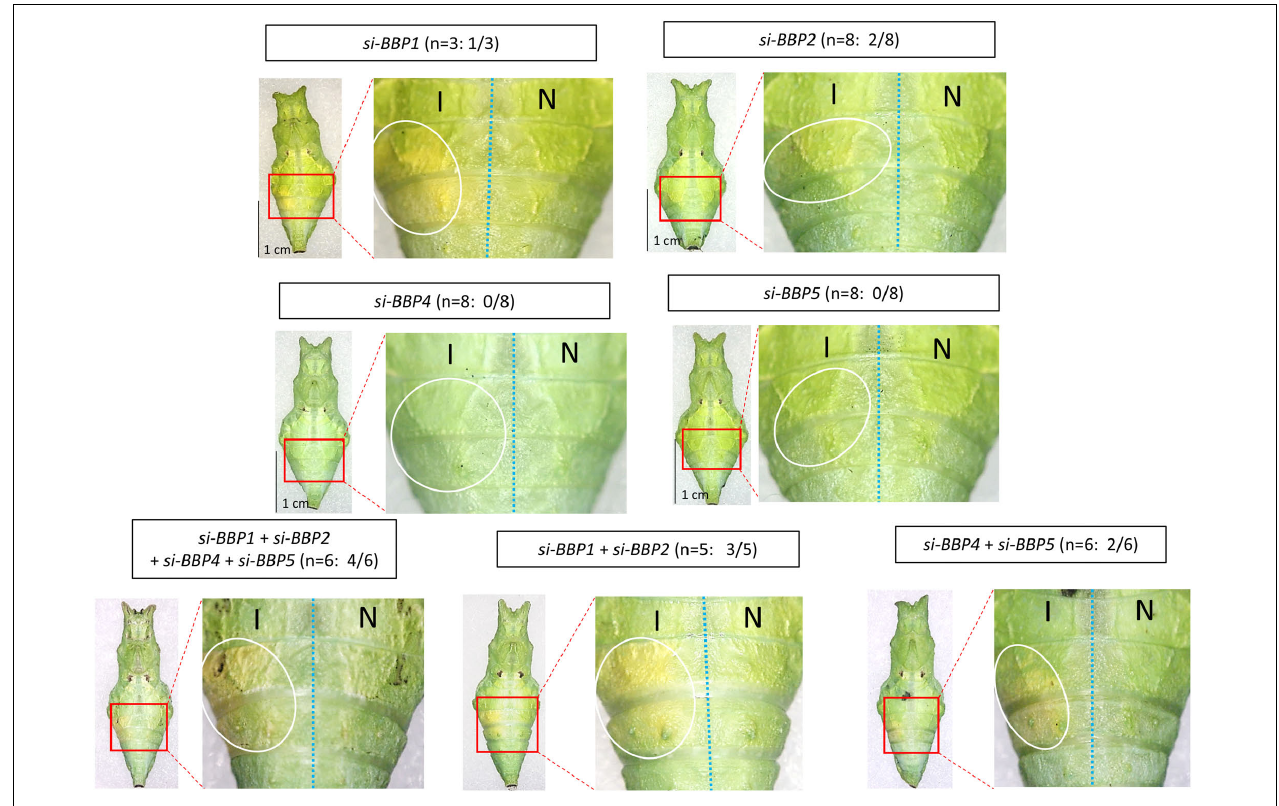
FIGURE 7 | Knockdown of BBP genes in green-conditioned pre-pupae. By an electroporation-mediated method, we introduced siRNAs into the left side of the fourth/fifth abdominal segments in pre-pupae just before the gut purge. We performed single knockdown for BBP1 , BBP2 , BBP4 , and BBP5 , multiple knockdown for four BBP genes simultaneously, and double knockdown for two BBP genes ( BBP1 + BBP2 , BBP4 + BBP5 ). The white circle indicates the siRNA-introduced region on the introduced side (I). The right half of the body is the side into which no siRNA was introduced (N). In some cases, the green color turned yellow in the introduced region. The number of samples showing phenotypic changes among the tested numbers is shown in parentheses (e.g., 1/3 for si-BBP1